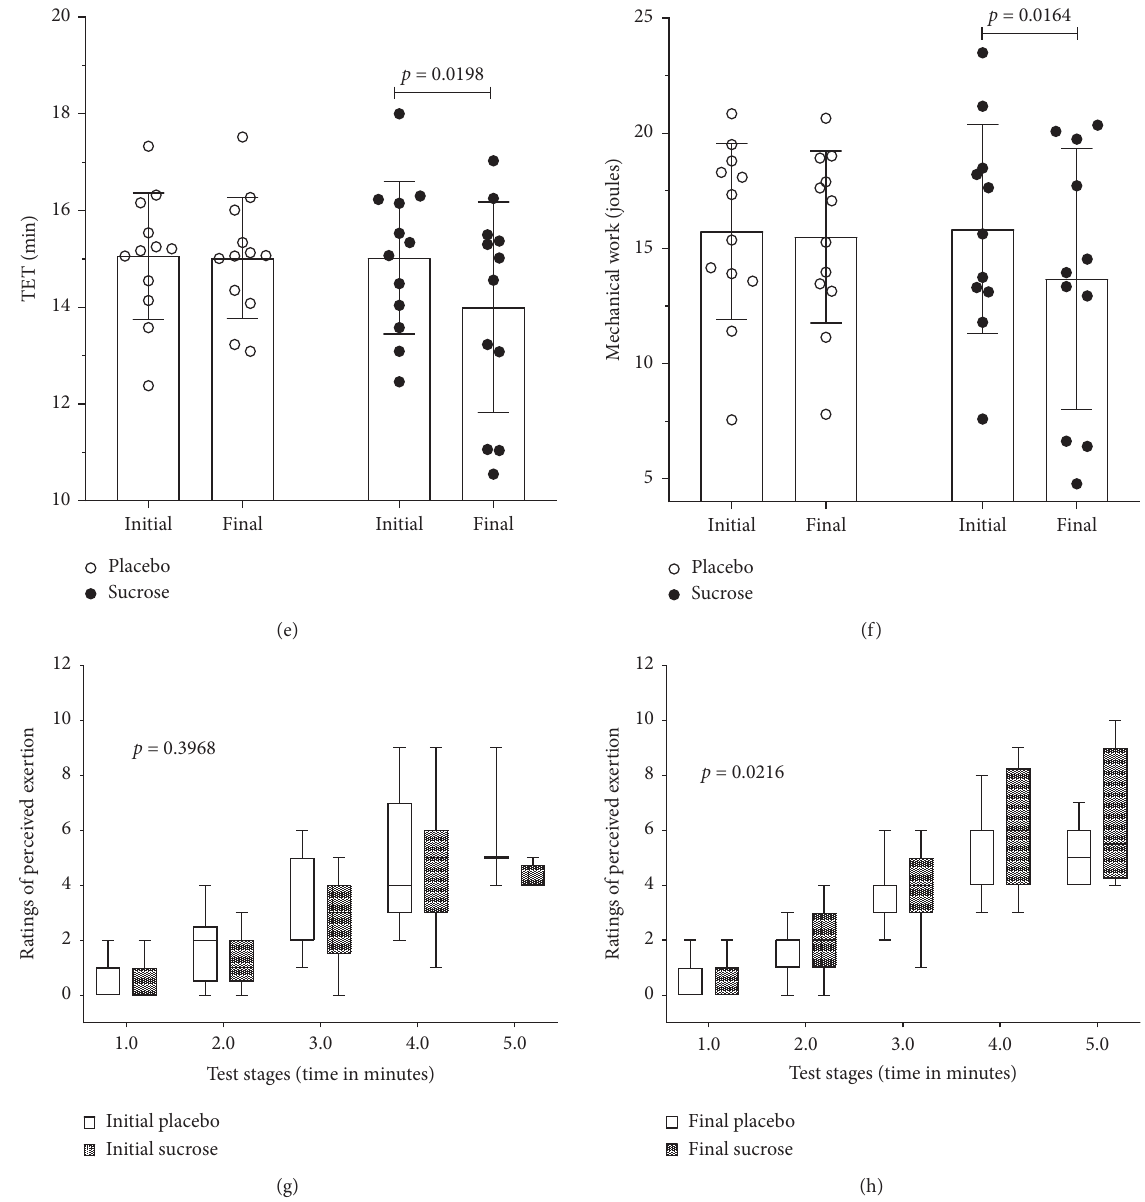
Figure 3: Physiological and performance parameters. (a) Rest systolic blood pressure (SBP), 95% CI of the difference between initial vs. final ( − 2.747 to 4.081), no differences, 95% CI of the difference between placebo vs. sucrose ( − 9.432 to 1.432), no difference (Bonferroni’s multiple comparisons test), n � 15. (b) Peak systolic blood pressure (SBP), 95% CI of the difference between initial vs. final ( − 22.90 to 2.900), no differences, 95% CI of the difference between placebo vs. sucrose ( − 21.05 to 11.05), p � 0 . 0386 (Bonferroni’s multiple comparisons test), n � 14. (c) Peak heart hate (HR), 95% CI of the difference between initial vs. final (0.07900 to 7.671), no differences, 95% CI of the difference between placebo vs. sucrose ( − 0.2743 to 9.085), p � 0 . 0297 (Bonferroni’s multiple comparisons test), n � 11. (d) VO 2 max, 95% CI of the difference between initial vs. final (0.07900 to 7.671), no differences, 95% CI of the difference between placebo vs. sucrose ( − 0.2743 to 9.085), p � 0 . 0378 (Bonferroni’s multiple comparisons test), n � 14. (e) Total exercise time (TET), 95% CI of the difference between initial vs. final (0.002003 to 1.066), no differences, 95% CI of the difference between placebo vs. sucrose ( − 0.7387 to 1.787), p � 0 . 0198 (Bonferroni’s multiple comparisons test), n � 12. (f) Mechanical work, 95% CI of the difference between initial vs. final (0.1359 to 2.260), no differences, 95% CI of the difference between placebo vs. sucrose ( − 2.878 to 4.599), p � 0 . 0164 (Bonferroni’s multiple comparisons test), n � 11; two-way repeated measure ANOVA followed by Bonferroni’s multiple comparisons test (a to f). (g) Ratings of perceived exertion; no differences between the two conditions, placebo and sucrose, during the performance of the physical test (initial) ( F � 0.9325; p � 0 . 0386), box and whisker (min to max). (h) Ratings of perceived exertion; there was a significant difference between the two conditions, placebo and sucrose, during the performance of the physical test (final) ( F � 3.980; p � 0 . 0216), box and whisker (min to max). Therefore, sucrose ingestion increases rates of perception exertion. Linear regression (g and h), null hypothesis � one curve for all datasets, and alternative hypoth- esis � different curves for each